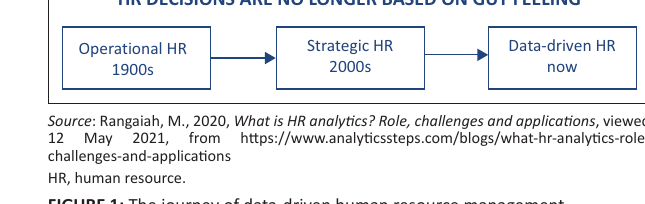
FIGURE 1: The journey of data-driven human resource